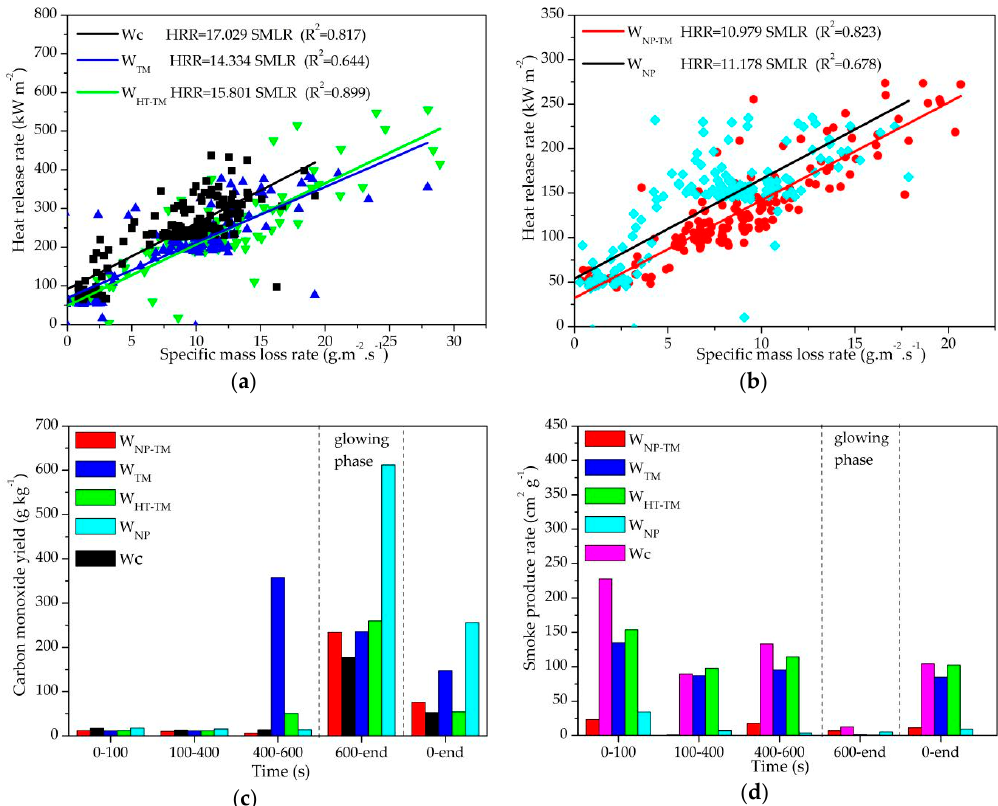
Figure 4. Correlation of heat release rate with specific mass loss rate ( a, b ), the CO yield ( c ), and smoke production rate ( d ) of the selected production rate ( d ) of the selected samples.